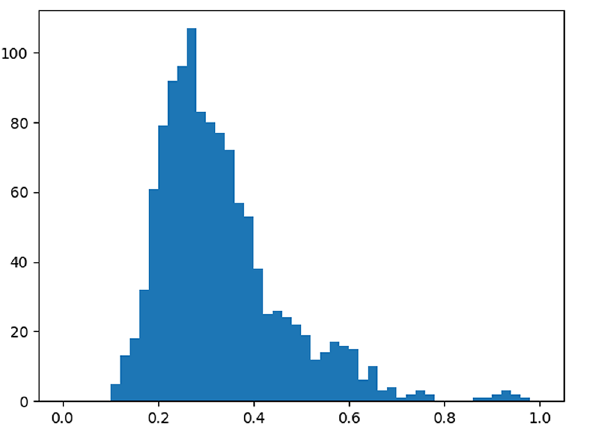
Figure 13. Histogram of circle difference scores in Fig.